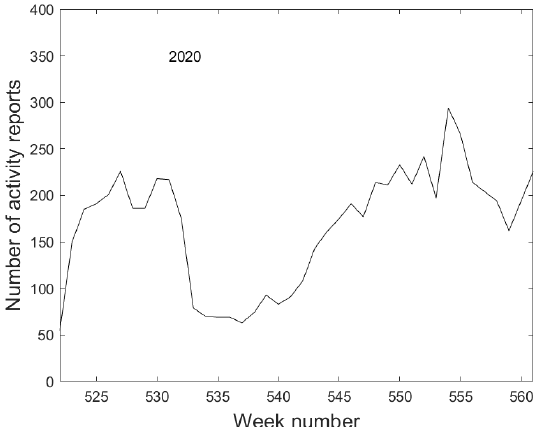
Figure 19. Time series of the weekly calls of the first 40 weeks of 2020 in Valencia.